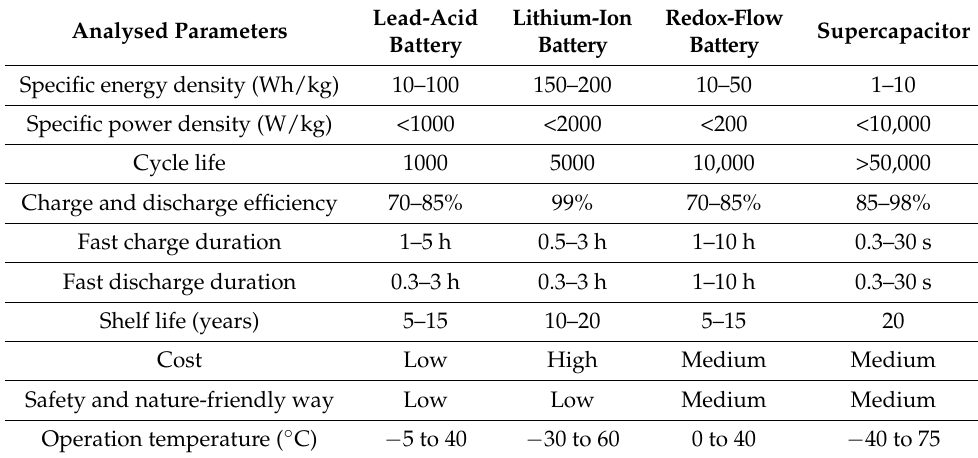
Table 1. Comparison of SCs with different types of batteries [3,12,132].